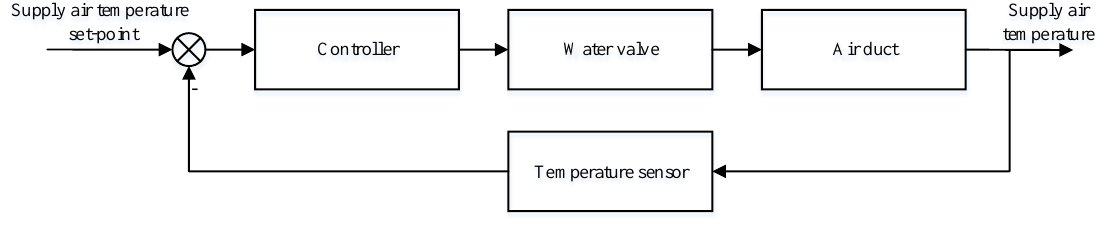
Figure 7. Structure of supply air temperature control.